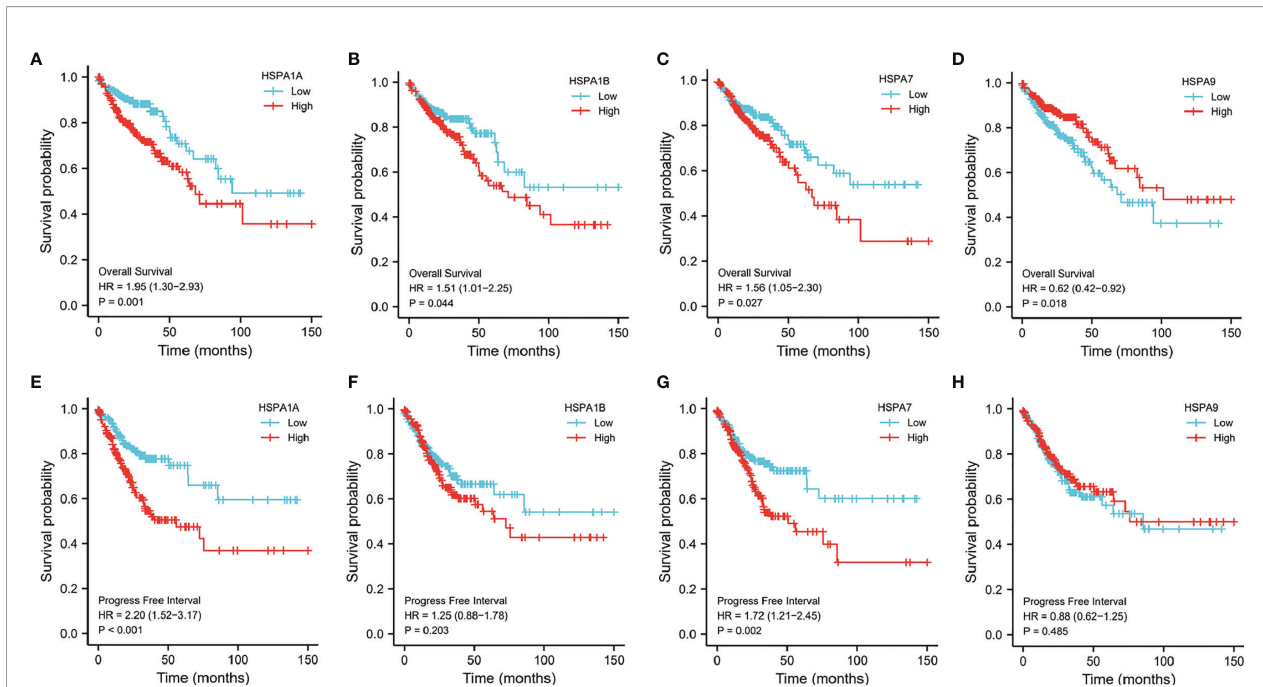
FIGURE 3 | Survivals analysis of patients with different HSPA1A, HSP1B, HSPA7, and HSPA9 expression levels by Kaplan – Meier method. (A) Overall survival for HSPA1A. (B) Overall survival for HSPA1B. (C) Overall survival for HSPA7. (D) Overall survival for HSPA9. (E) Progress-free interval for HSPA1A. (F) Progress free interval for HSPA1B. (G) Progress free interval for HSPA7. (H) Progress free interval for